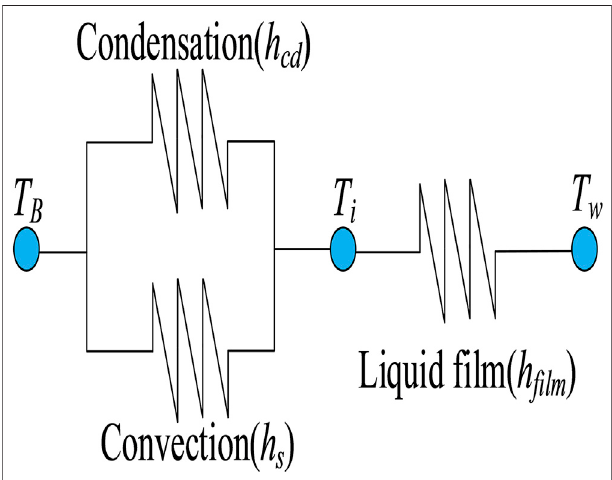
FIGURE 1 | Scheme of the thermal resistances through the